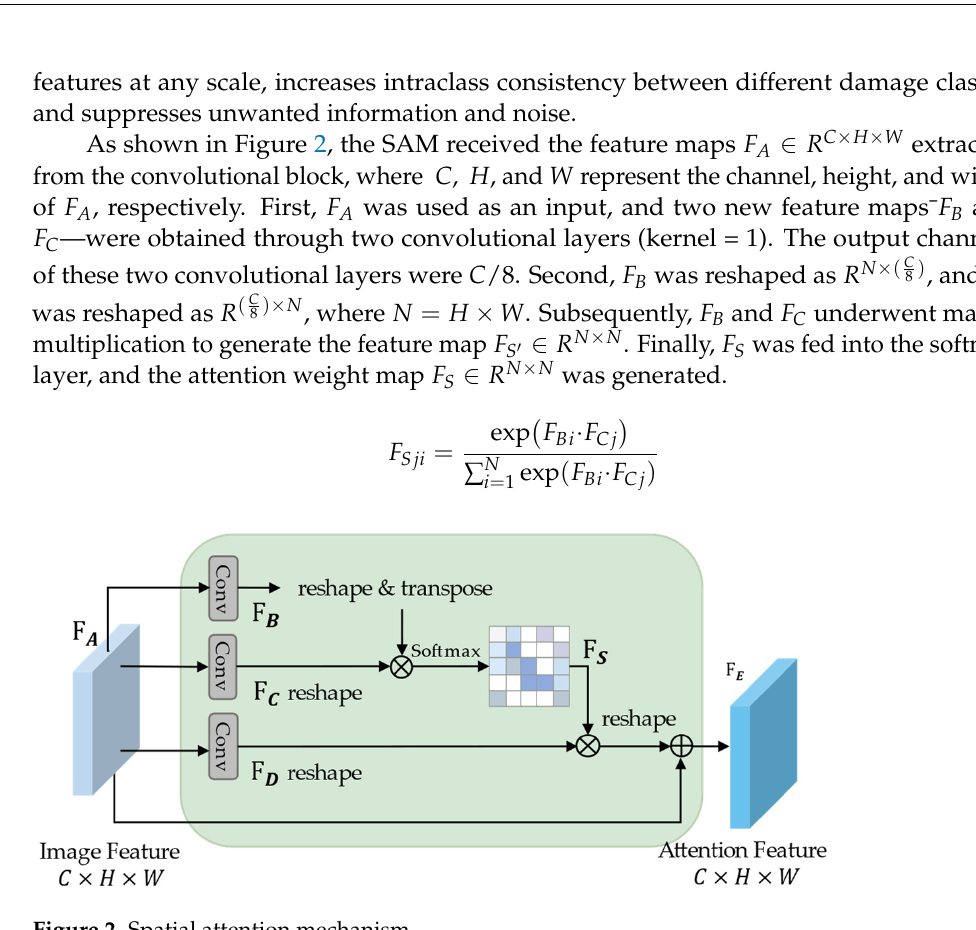
Figure 2. Spatial attention mechanism.